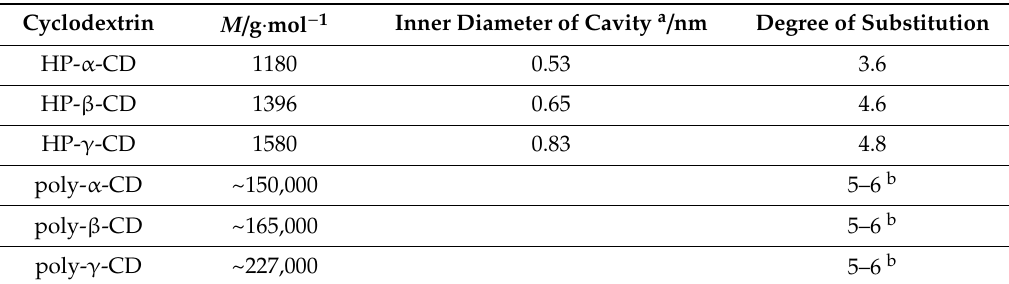
Table 2. Main properties of the applied cyclodextrin